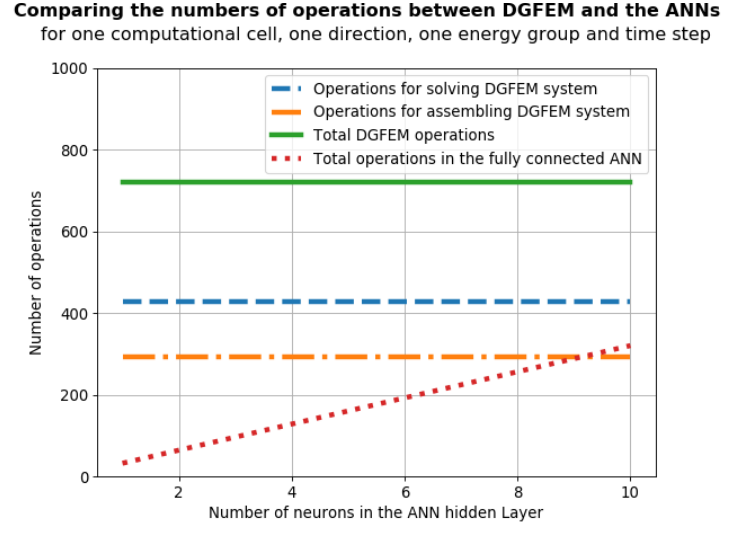
Figure 3: Comparison of the number of operations required for the assembly and solution by Gauss Elimination of system vs the number of operations required for a feed-forward evaluation of the ANN.